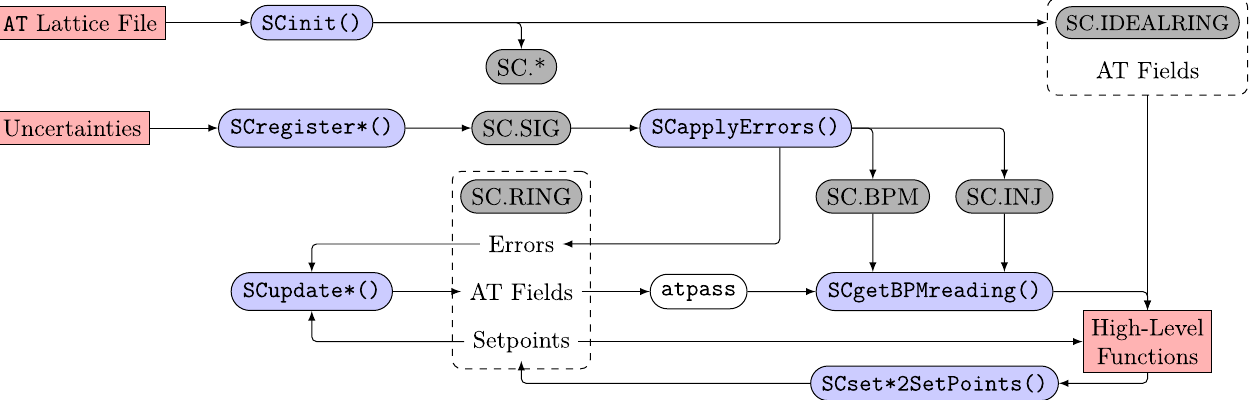
FIG. 1. Schematic drawing of the workflow of the SC toolkit. The input for high-level functions are only the ideal lattice, BPM readings as well as machine setpoints. An important feature of the toolkit is the clear distinction between machine setpoints and machine model